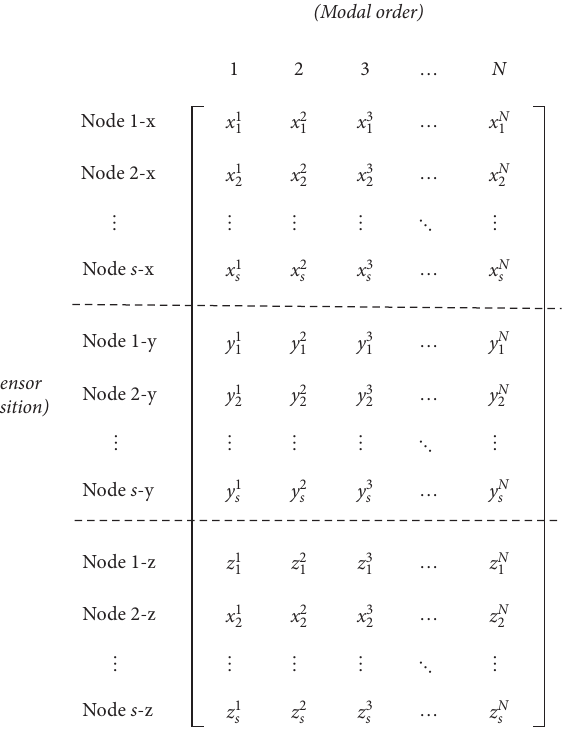
Figure 2: The modal shape matrix of FE